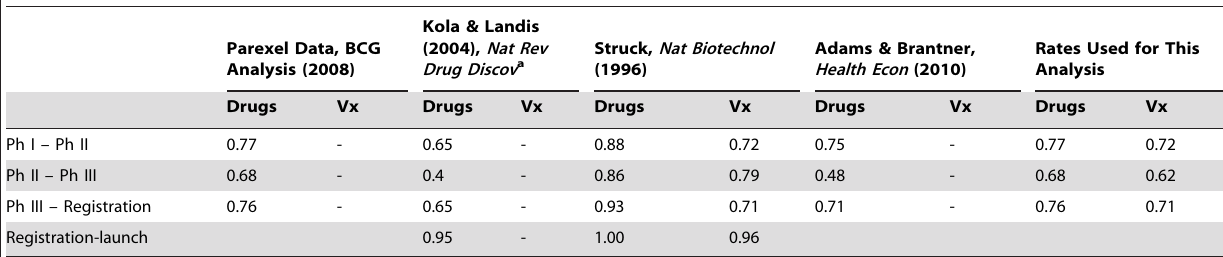
Table 1. Average probability of success (POS) rates from various